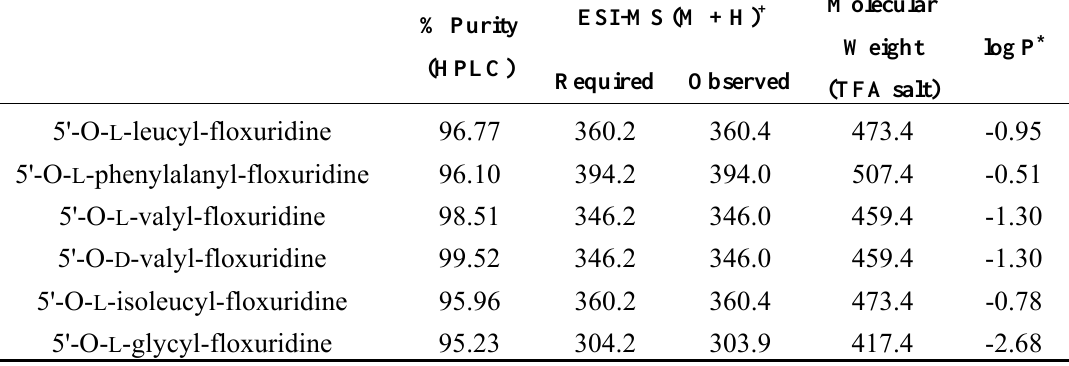
Table 1 . Analytical data for amino acid ester prodrugs of floxuridine.